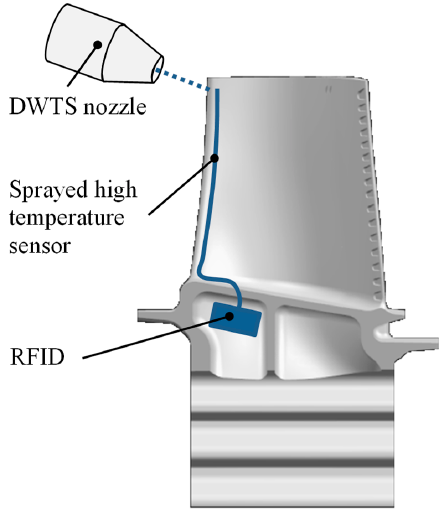
Figure 25 . Principle DWTS on a turbine blade. Figure 26. Principle DWTS on a turbine